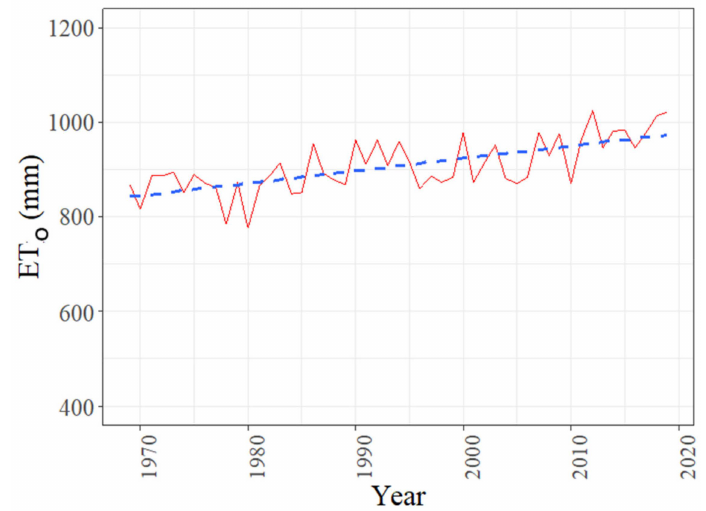
Figure 3. Yearly values of ET o